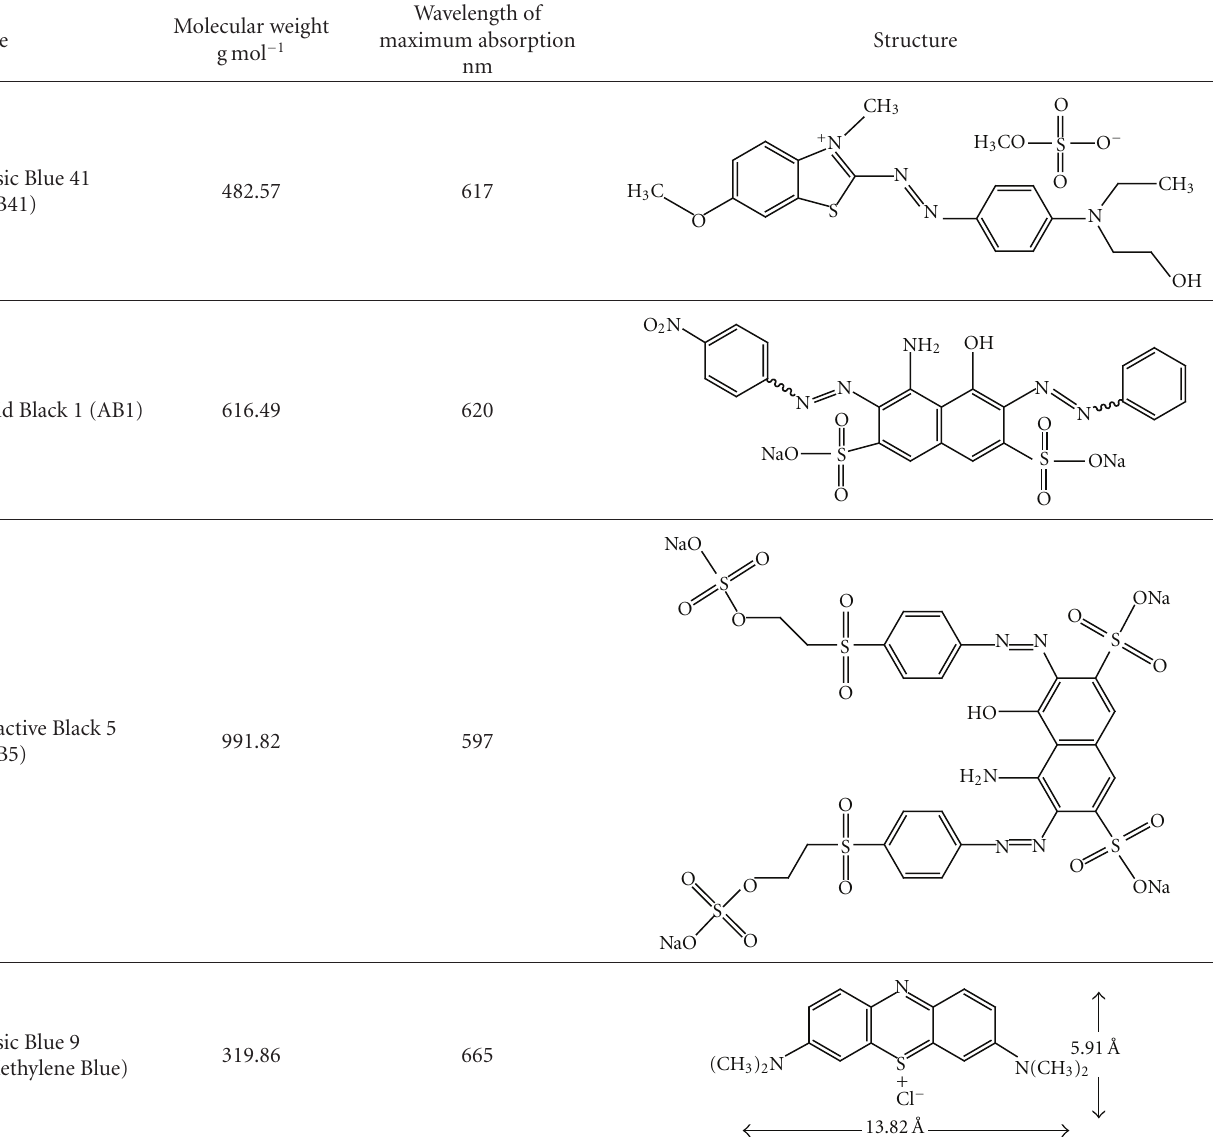
Table 1: Structure and properties of